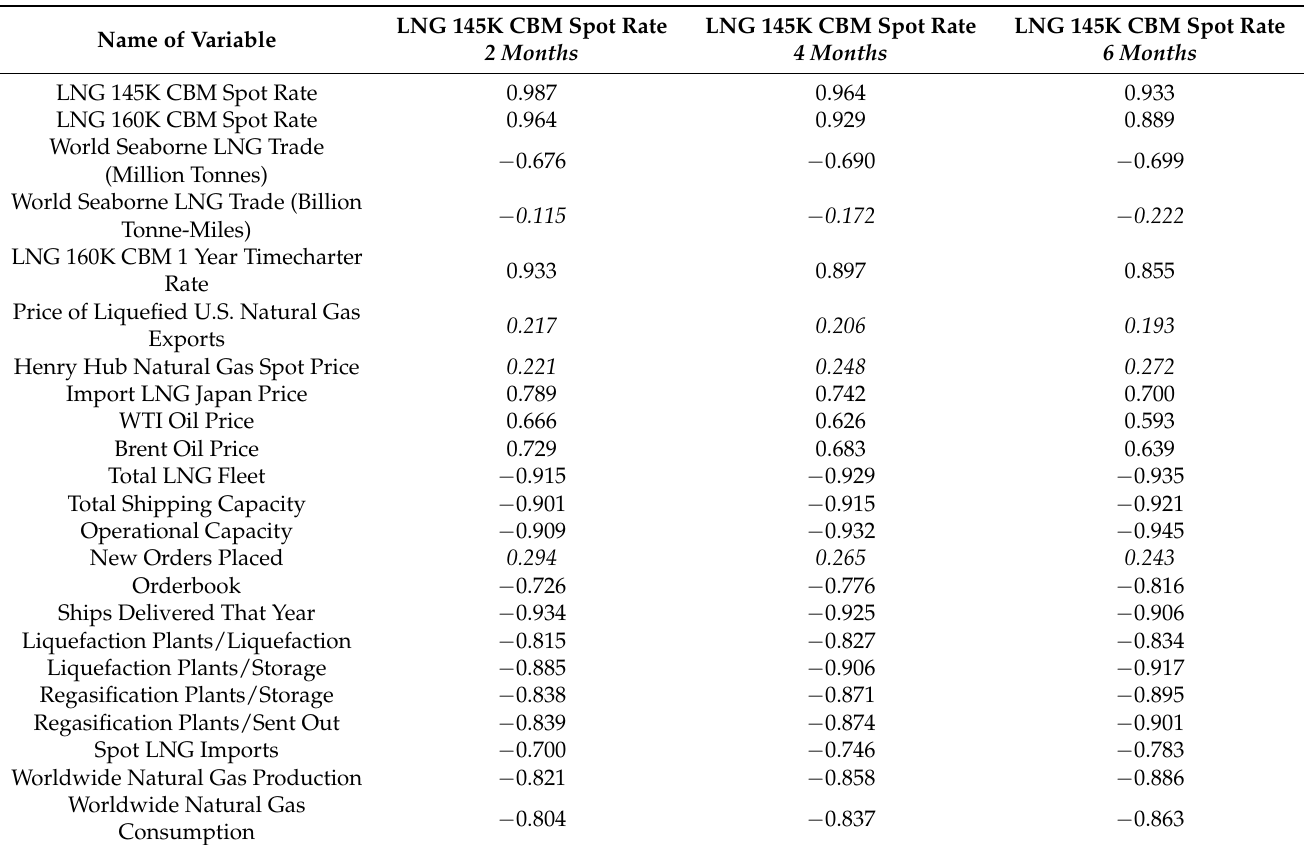
Table 5. Correlation coefficients between the prediction variable and the other variables for 2, 4 and 6 months.